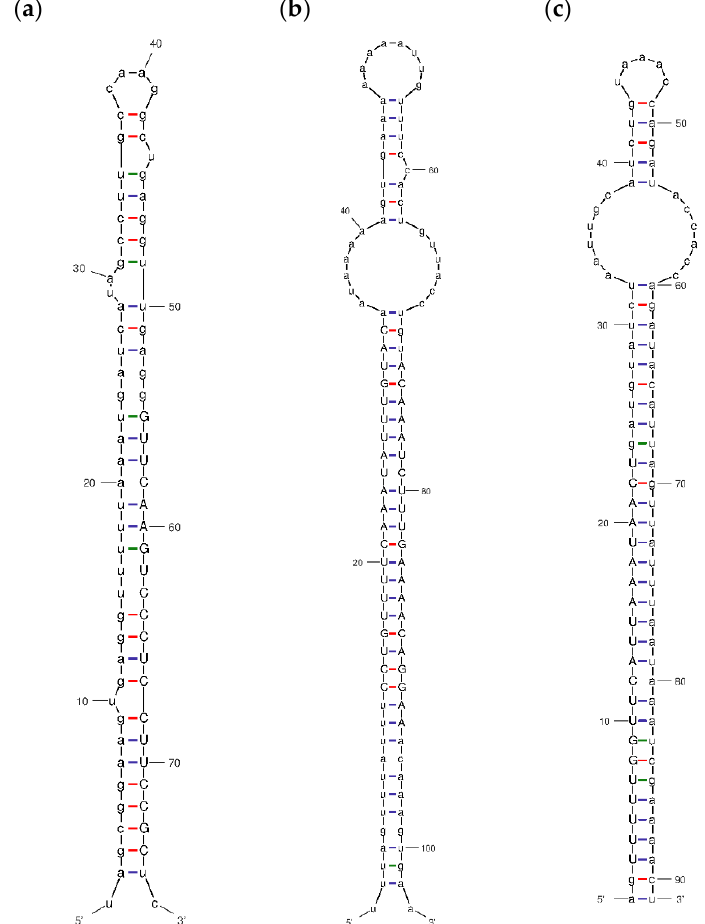
Figure 4. The secondary structure of the miRNA precursors of ame-miRN1 ( a ), ame-miRN8 and ame-miRN9 ( b ), and ame-miRN-14 ( c ). The mature sequences of the miRNAs were shown in uppercase. These graphs were generated by using mfold web server.